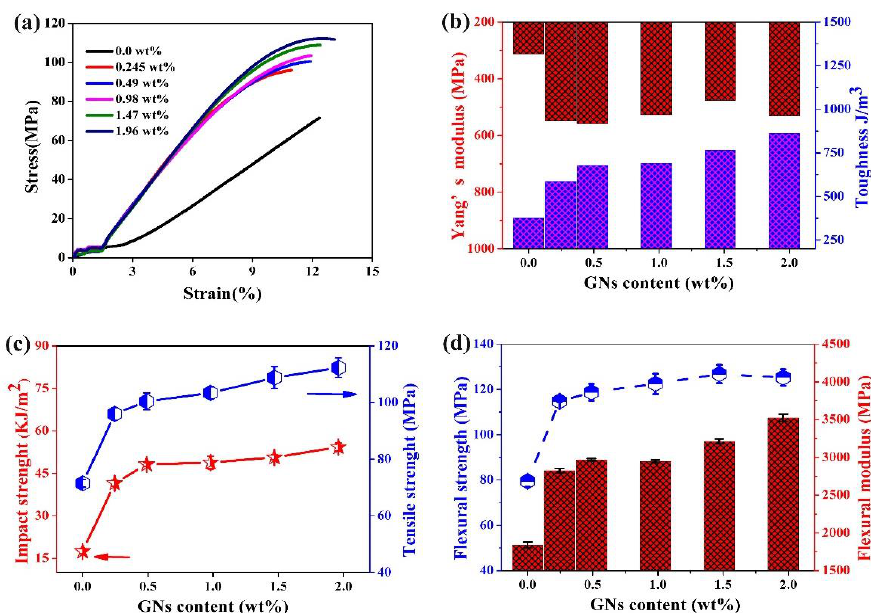
Figure 11. ( a ) typical curves of stress-strain; ( b ) Young’s modulus and toughness; ( c ) Impact strength and tensile strength; ( d ) flexural strength and modulus of neat epoxy and its composites.